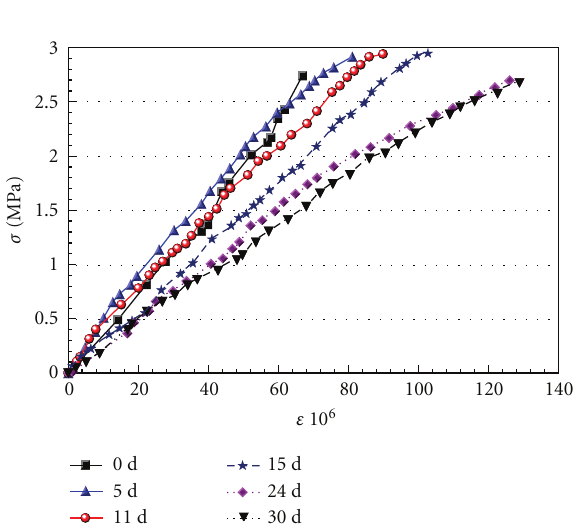
Figure 12: Ascending branch of stress-strain curves of concrete specimen corroded for di ff erent periods.